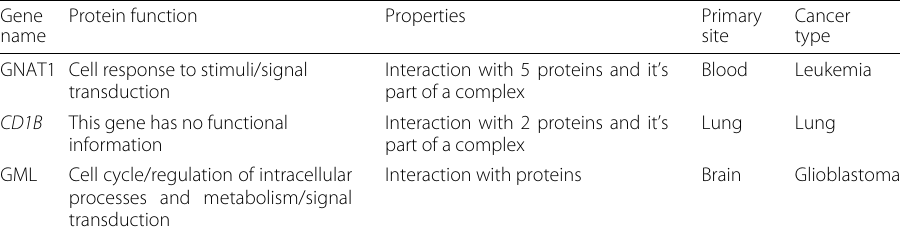
Table 5 Third analysis: cancer genes reported only by the Shapley value (and not by other centrality